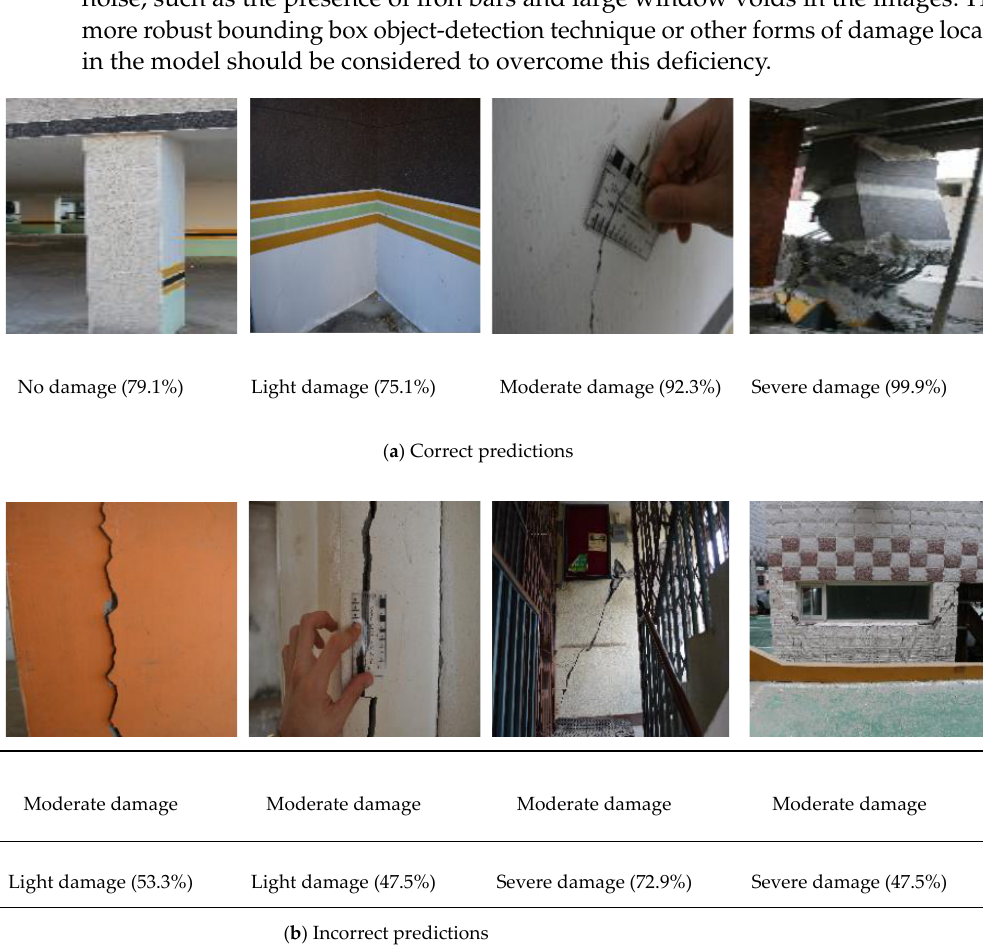
Figure 11. Sample testing images of structural damage with predicted probability for cases of ( a ) correct and ( b ) incorrect predictions.